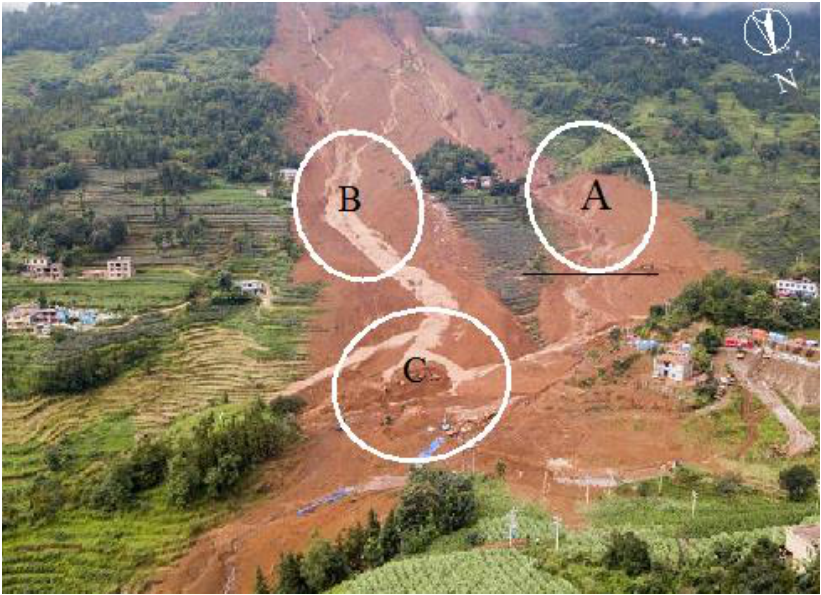
Figure 5. Three points A, B, and C of the rescue areas (Source: http://gz.people.com.cn/n2/2019/0724/c194849-33174976-2.html).